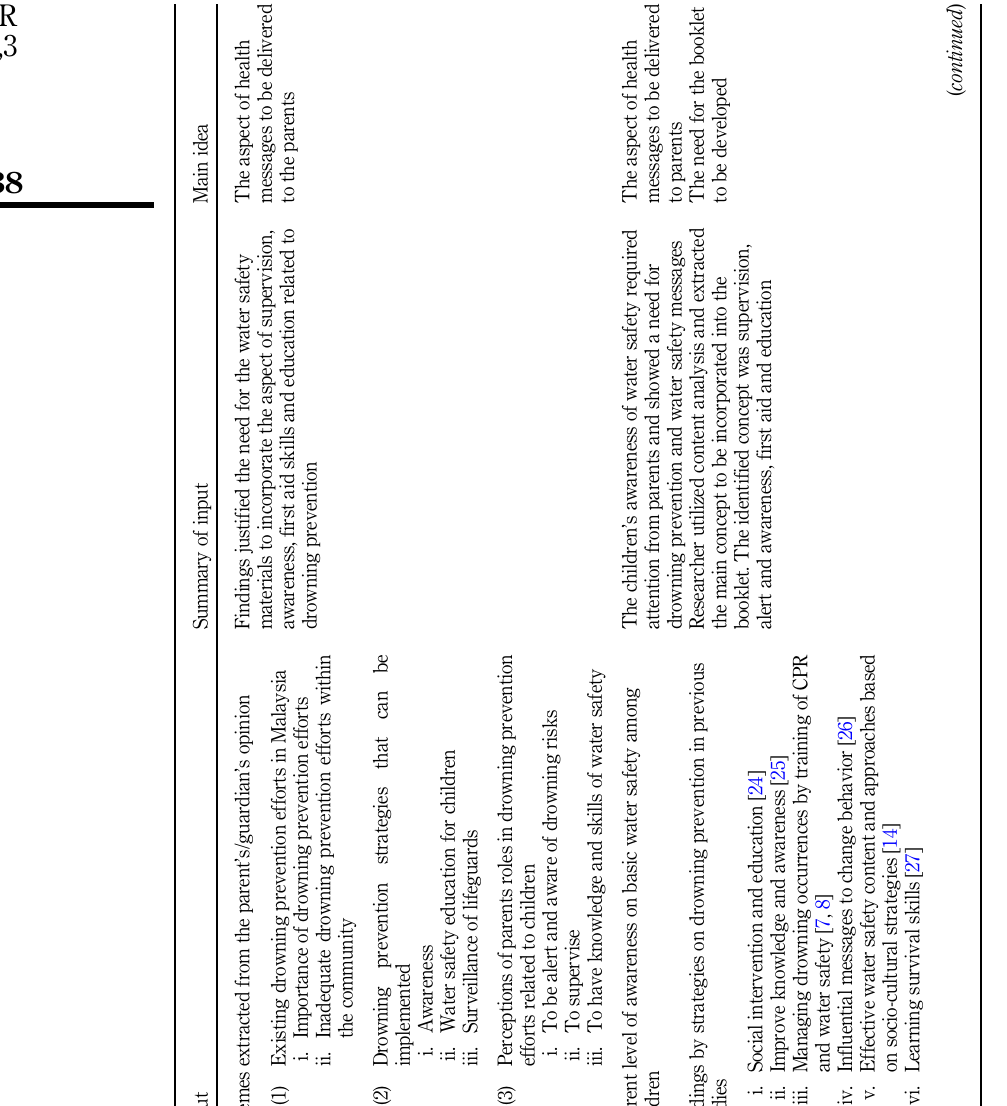
Table II. Sources of input for the contentdevelopment of the health